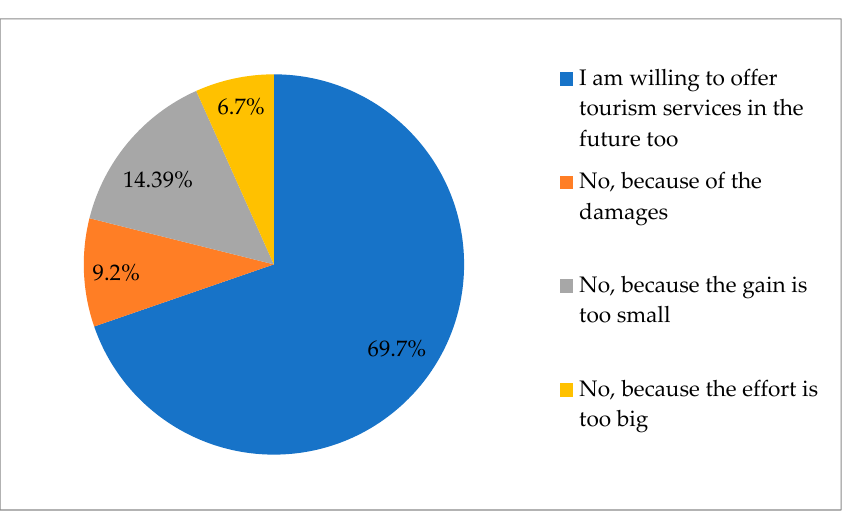
tinue in the future (Figure 2).